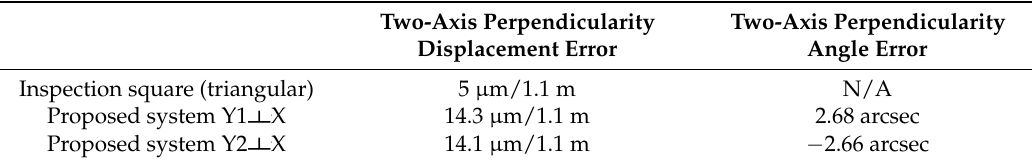
Table 8. The parallelism error measurement